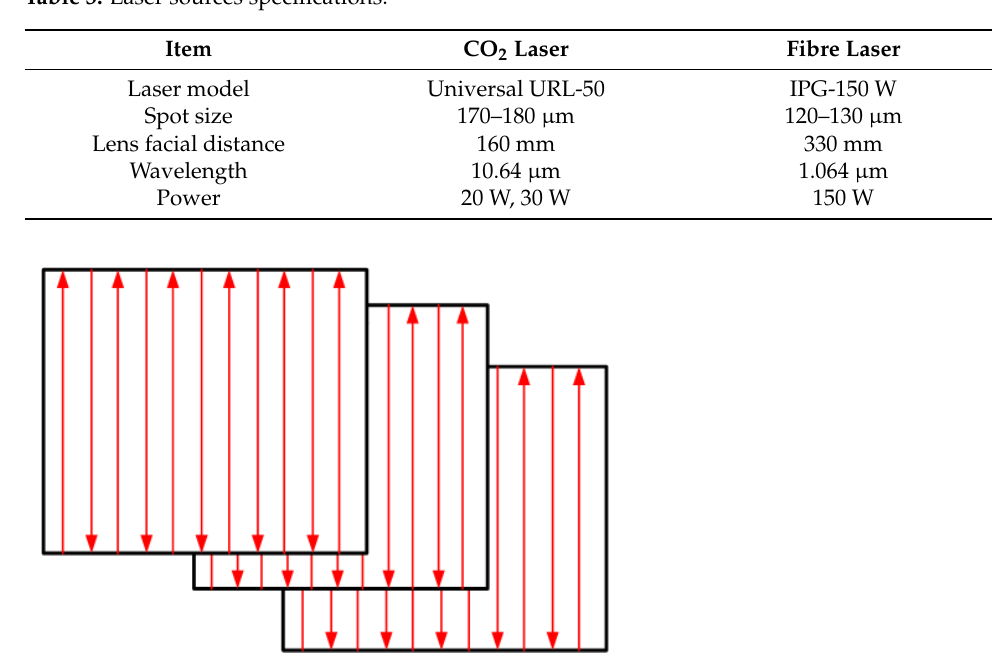
Figure 8. A zig-zag scanning strategy was used in this study as recommended by Abdelmoula et al.